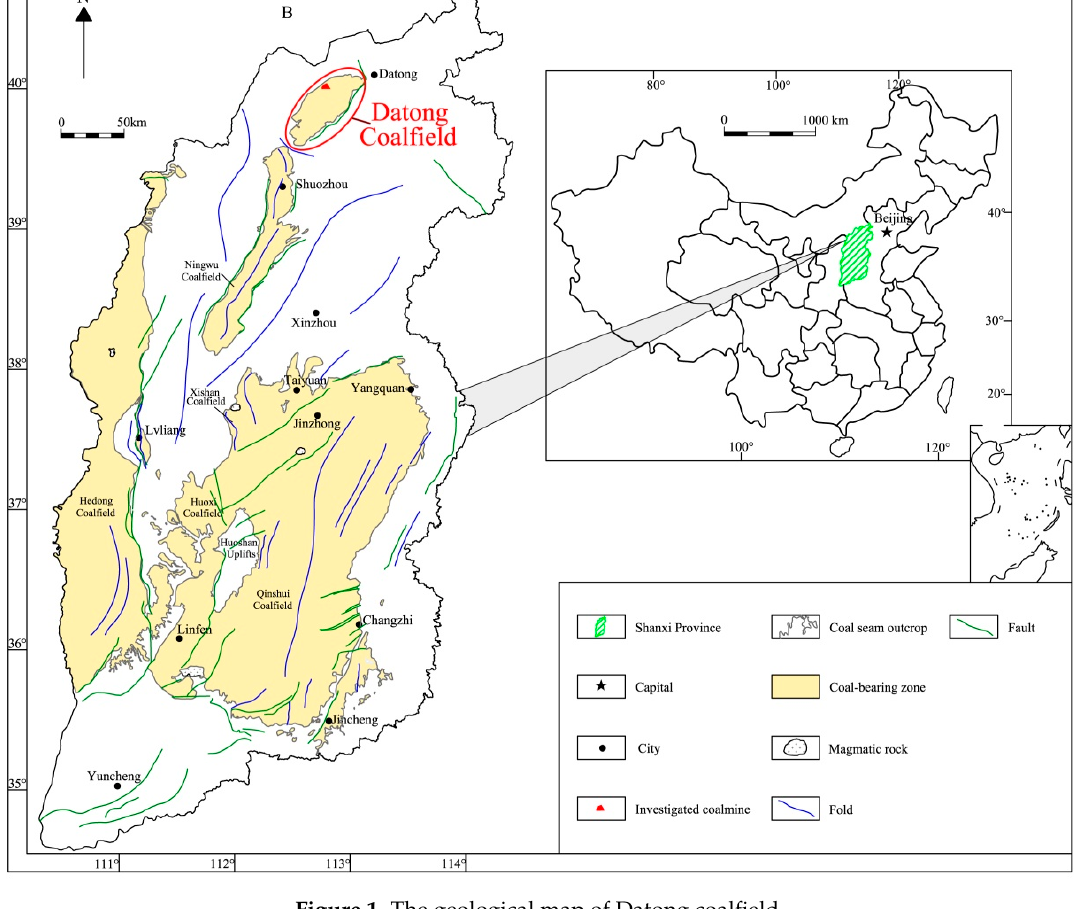
Figure 1. The geological map of Datong coalfield.